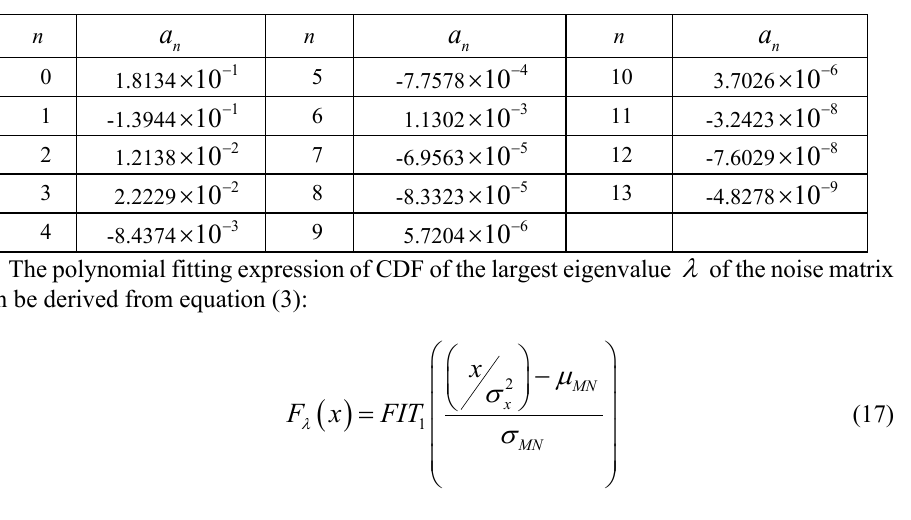
Table 4. PDF polynomial fit coefficients for first-order Tracy-Widom